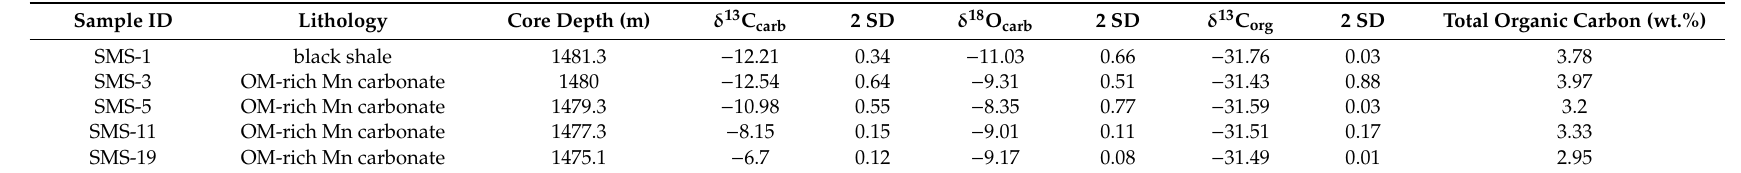
Table 2. C and O isotope compositions in carbonate.